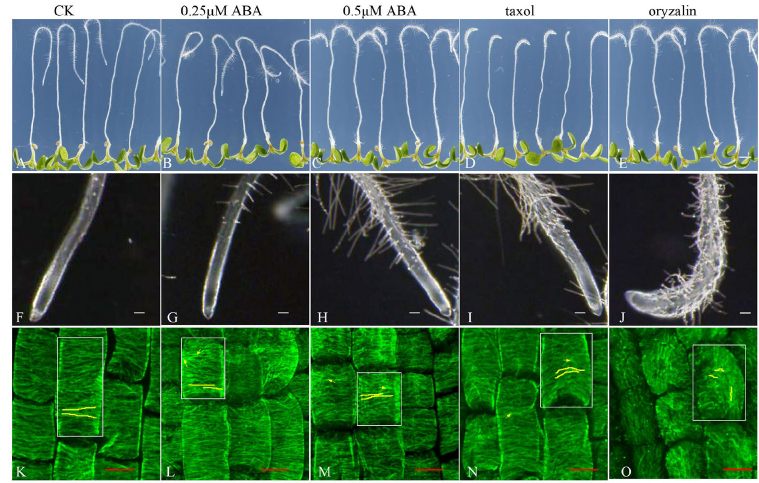
Figure 5. Effects of ABA, taxol, and oryzalin on cortical microtubules of the transition zone of root epidermal cells and phenotypes of A. thaliana seedlings. A. thaliana grown in an MS medium for 5 days was arranged in an MS medium without drugs as control and in an MS medium containing 0.25 μmol L −1 ABA, 0.5 μmol L −1 ABA, 0.3 μmol L −1 oryzalin or 1 μmol L −1 Taxol, respectively, as indicated in the figure. Phenotypes of seedlings (subfigures A – O ), enlarged root tips (subfigures A – O ), and cortical microtubules (subfigures A – O ) were photographed after 2 days, and the images of their root tips were enlarged using a Zeiss LSM 510 META confocal microscope. The yellow lines processed by software Image J represent the change of length, direction, and structure of the microtubules in the selected cells, and the yellow arrows indicate bundles of microtubules. Scale bars represent 1 mm for seedlings, 100 μm for enlarged root tips, and 10 μm for fluorescence views of microtubules.